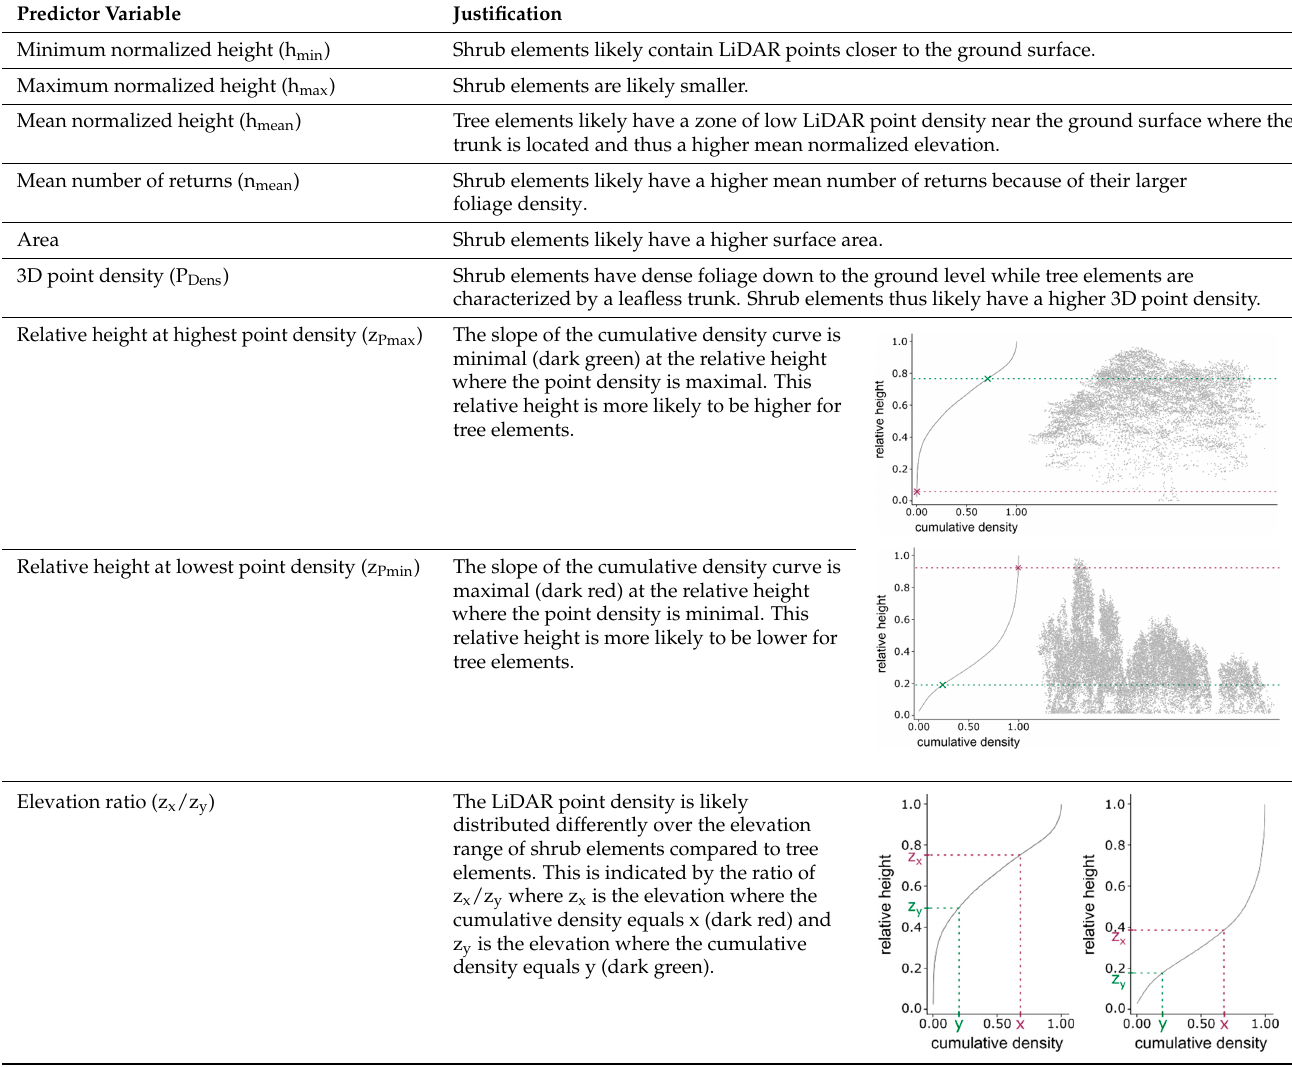
Table 4. Candidate features for the classification of the 2D vLE objects and justification for their